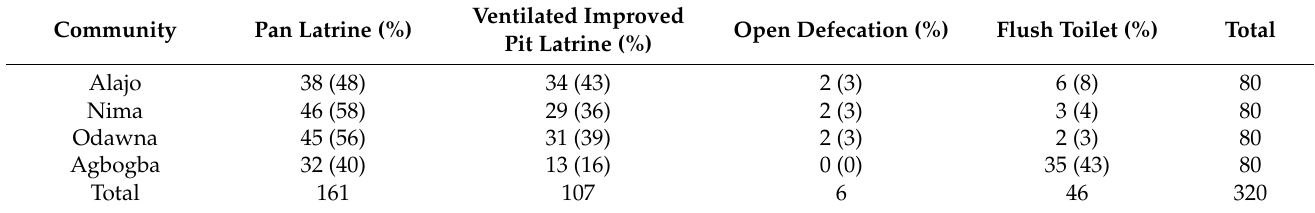
Table 1. Types of sanitation facilities in the study communities in